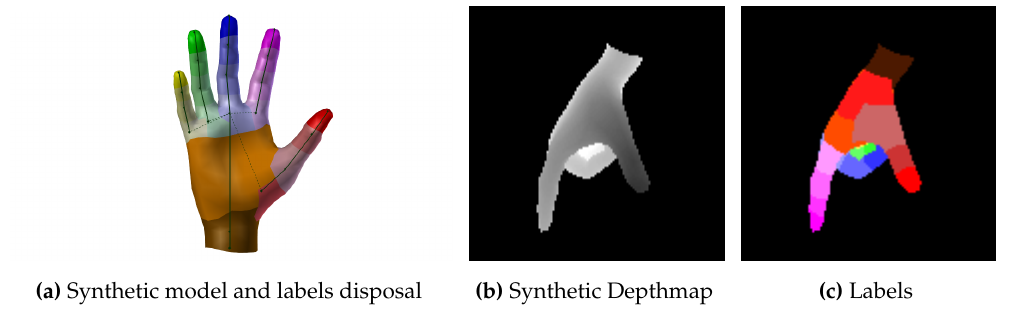
Figure 1. Model ( a ) and input data ( b , c ) used for training the RF